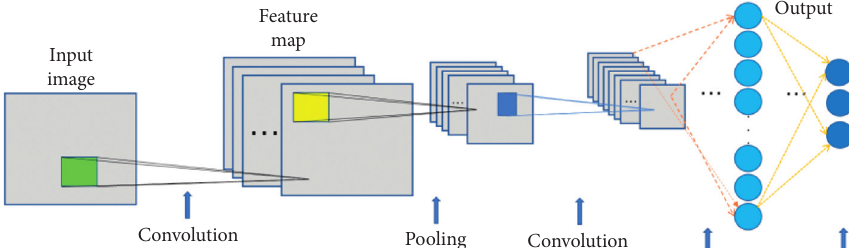
Figure 1: The representative CNN